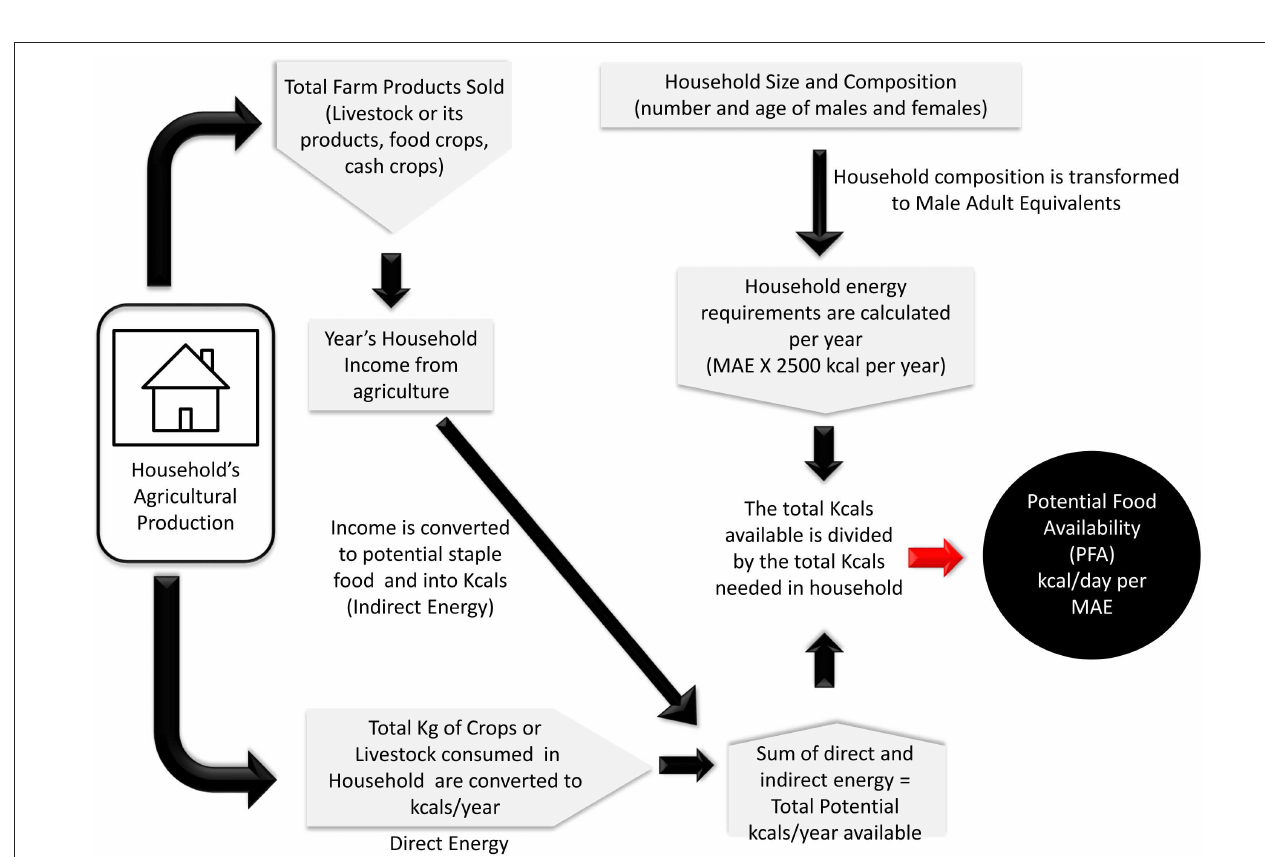
FIGURE 2 | Representation of household food provisioning process expressed as potential food availability in kcal.